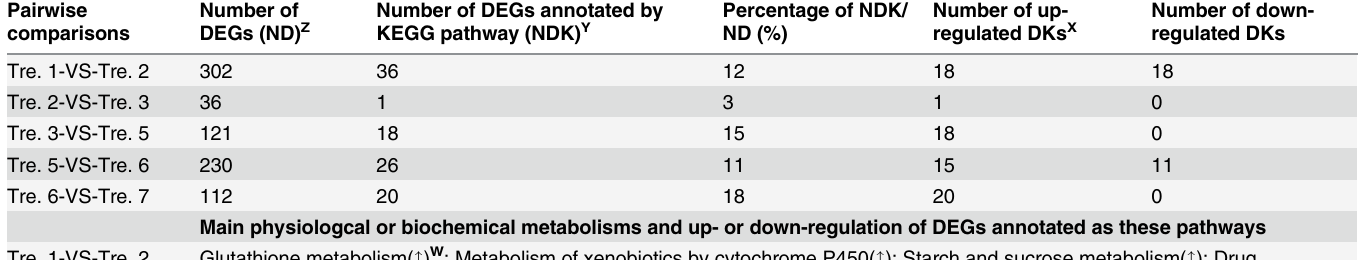
Table 10. DEGs and main physiologcal or biochemical metabolisms identi fi ed by KEGG pathway annotation during fi ve adjacent dormant phases. Pairwise